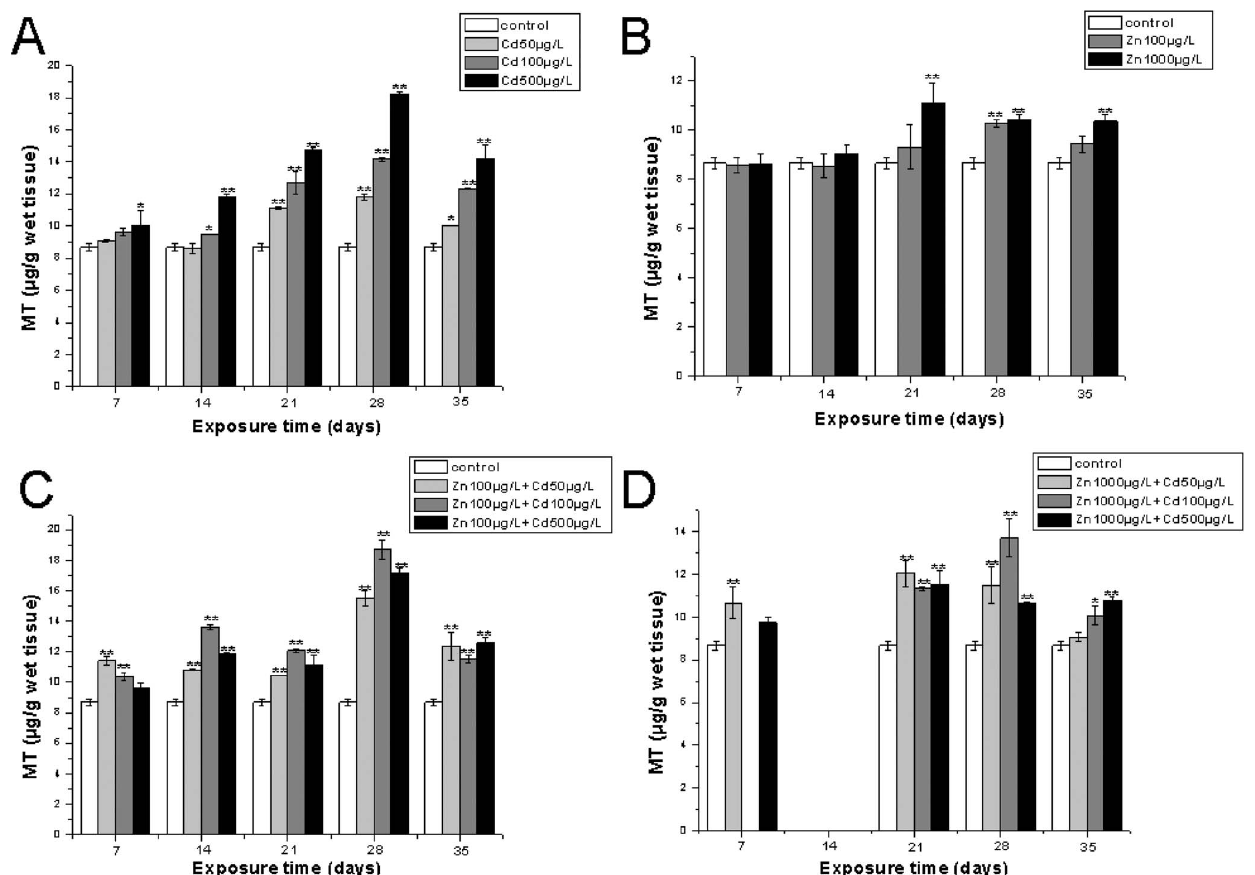
Figure 3. The MT levels in the gills of S.henanense exposed to Cd and Zn as either single or both metals combined for 7, 14, 21, 28, or 35days. Data were expressed as mean values 6 standard error of four animals. Statistical significance was denoted by *P , 0.05, **P , 0.01 compared to the respective control crabs.